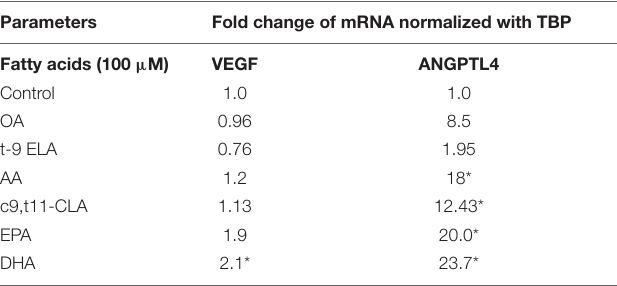
TABLE 1 | Shows the effects of fatty acids on the expression of mRNAs of angiogenic growth factors in these cells.